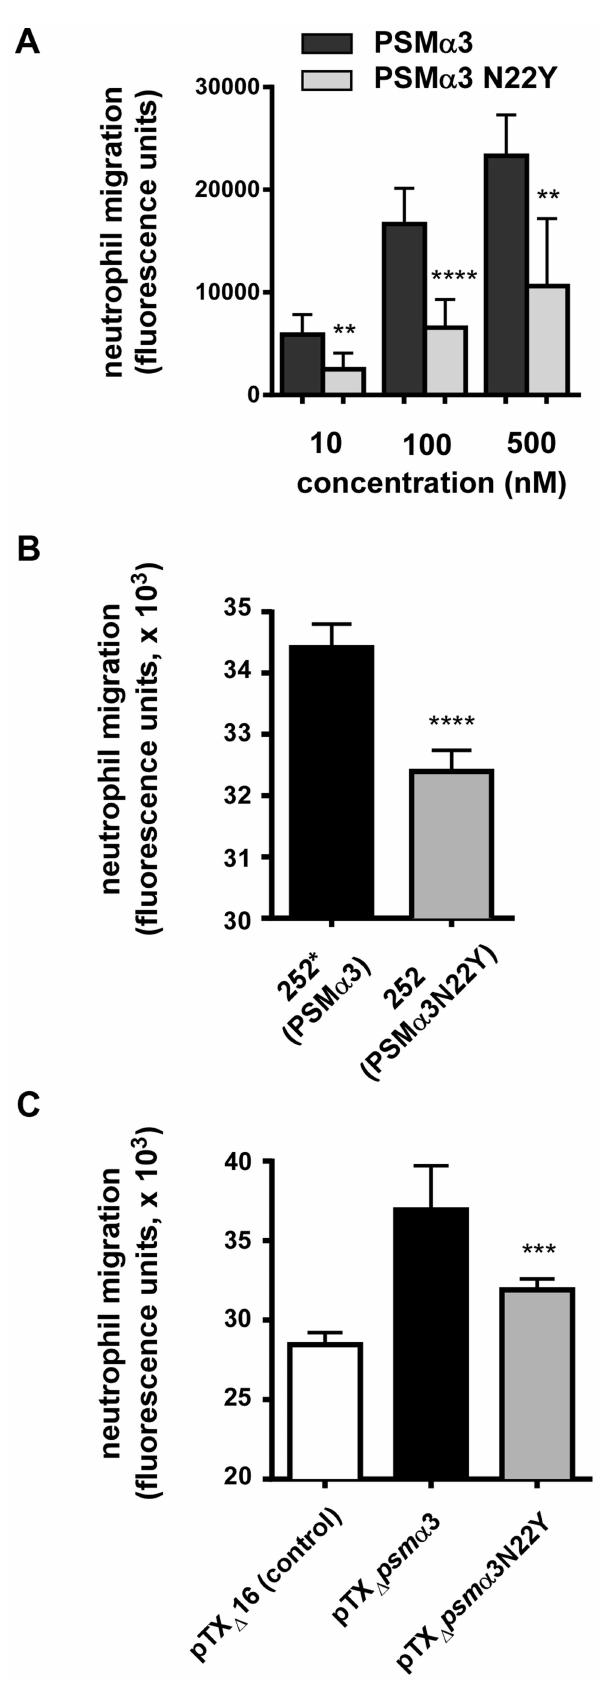
Figure 3. PSM a 3N22Y has decreased chemotactic activity toward human neutrophils. (A) Chemotaxis of human neutrophils (neutrophil migration) was measured using a transwell system with synthetic peptides at the indicated concentrations. Neutrophils were from three donors and the measurements were performed in quadruplicate. **, p , 0.01; ****, p , 0.0001. (B) Chemotaxis of human neutrophils tested with culture filtrates (diluted 1:100) of strains MRSA252 (252, expressing PSM a 3N22Y) and 252* (MRSA252 altered to express PSM a 3); ****, p , 0.0001. Data are from two donors with triplicate measurements. (C) Chemotaxis of human neutrophils tested with culture filtrates (diluted 1:100) of strains expressing PSM a 3 or PSM a 3N22Y constitutively from plasmids; pTX D 16 is the empty control plasmid. ***, p , 0.001 (versus pTX D psm a 3). Data are from two donors with triplicate